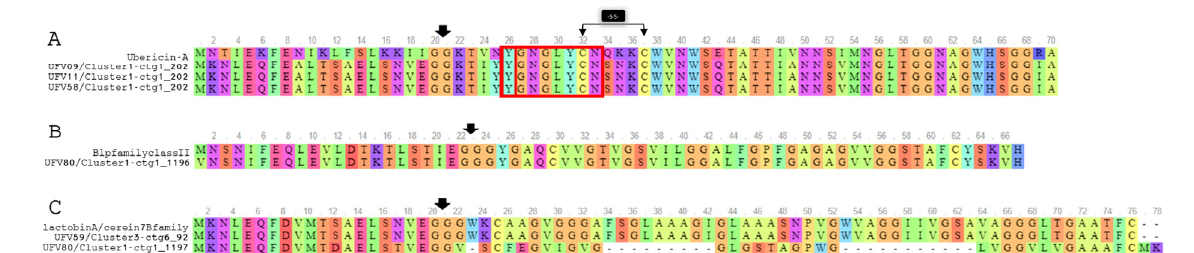
Figure 6. Visualization of the multiple ‑ sequence alignment from Clustal Omega (plotted using http://msa.biojs.net/app/, access on14 June 2021) of the S. lutetienses precursor peptides identified in this study. The colors show the conservations of the amino acid at each position of the alignments. ( A ) Precursor peptides extracted from the S. lutetiensis UFV09, UFV11, and UFV58 clusters showing sequence similarity with Ubericin A. The red box represents the amino acids of the conserved region (YGNGVXC) of the ‘pediocin box’ motif. ( B ) Alignment of the putative precursor peptide from cluster 1 ‑ ctg1_1196 of S. lutetienses UFV80, and ( C ) Alignment of the precursor peptide from cluster 1 ‑ ctg1_1197 of S. lutetienses UFV80 and cluster 3 ‑ ctg6_92 of S. lutetienses UFV59 with the lactobinA/cerein7B family. The black arrows indicate the leader peptide cleavage site and disulfide bond.